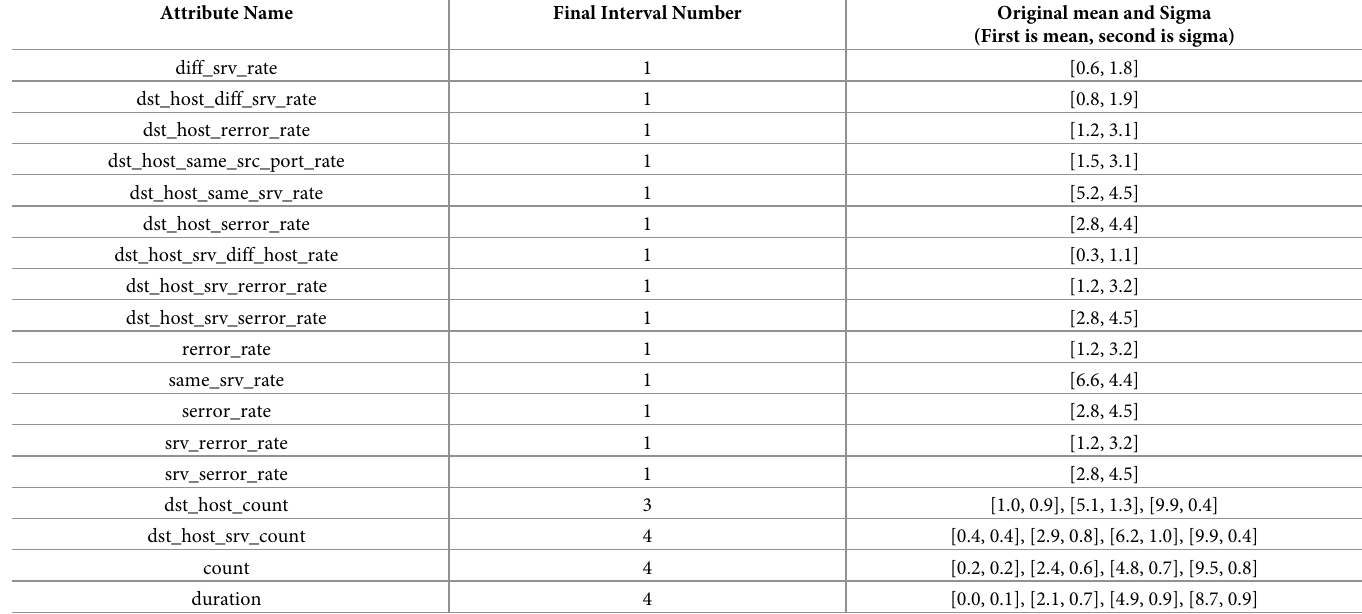
Table 4. Final interval number of selected